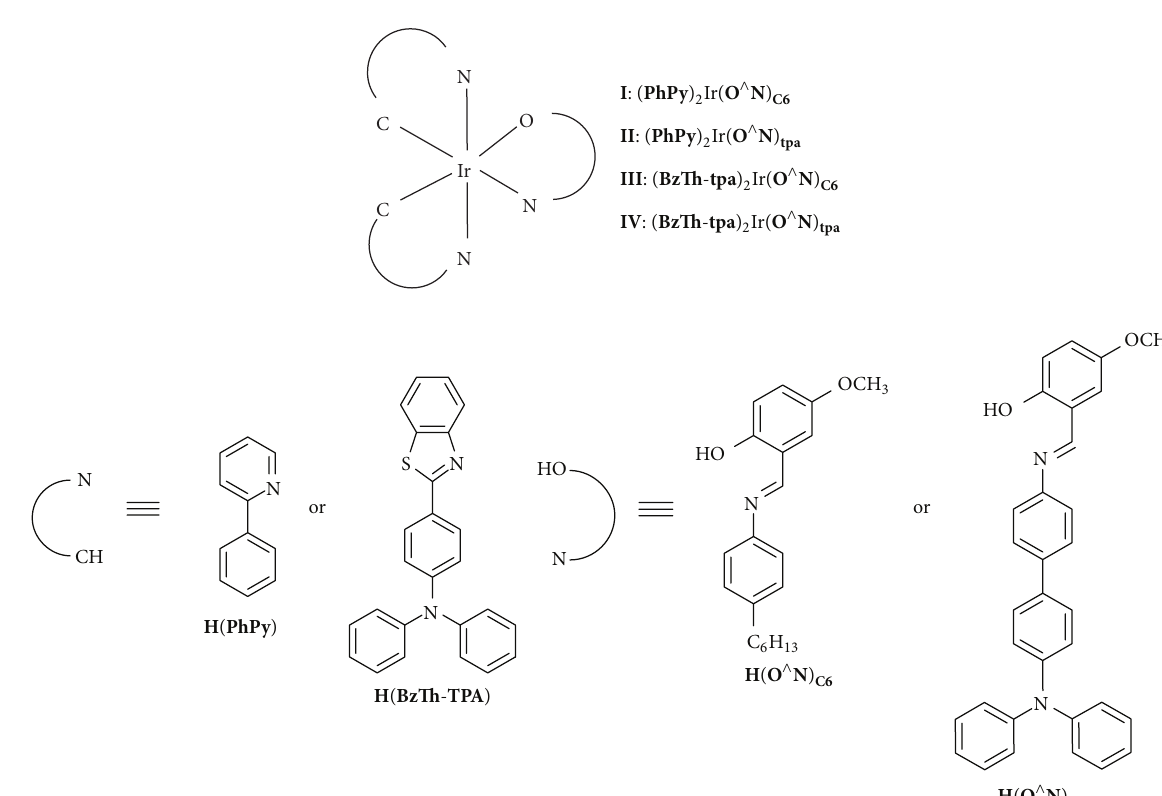
Figure 1: Molecular structures of the synthesized Ir(III) complexes I – IV and the O-, N-coordinated